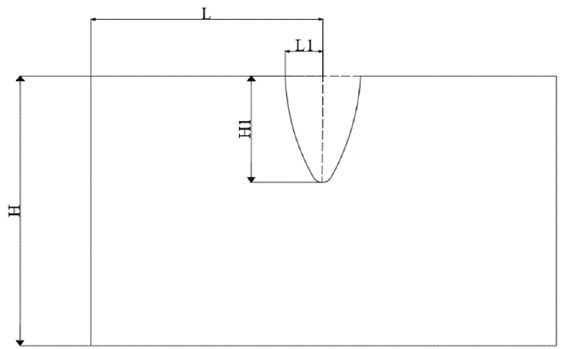
Figure 8. Schematic diagram of surface damage and penetration depth.